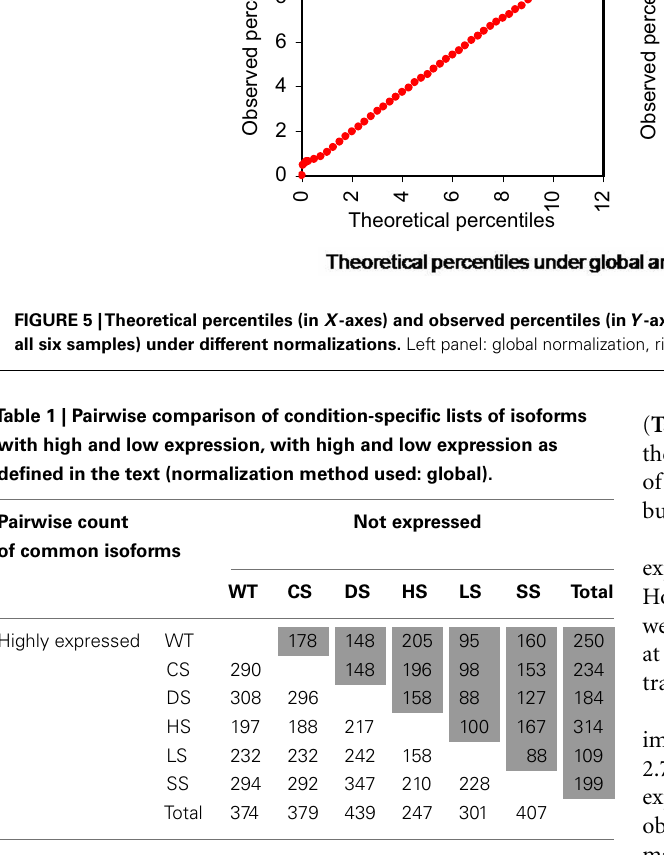
The entries above diagonal shaded in gray color are low-expressed genes and thosebelowdiagonal(notshaded)arehighlyexpressedgenes,inbothconditions.